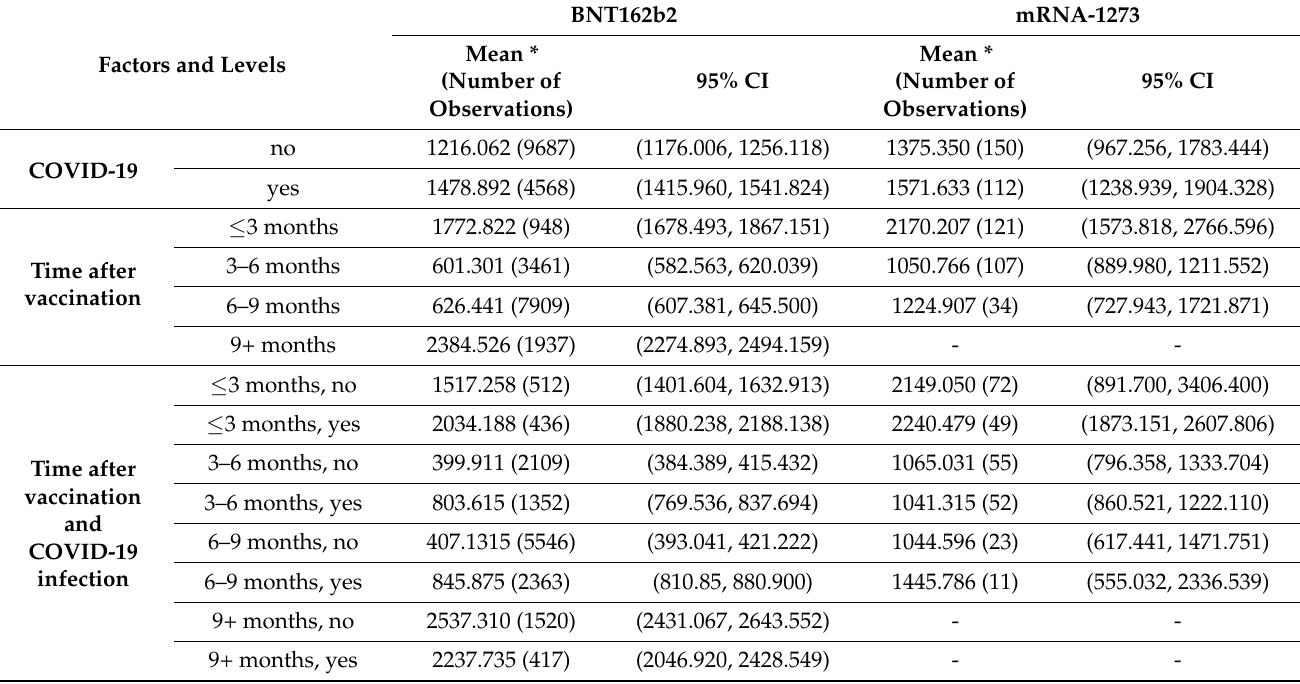
Table 7. Estimated marginal means, the 95%-confidence intervals, and the numbers of observations for each group determined by levels of prior COVID-19 infection, the time after vaccination, and its interaction for BNT162b2 and